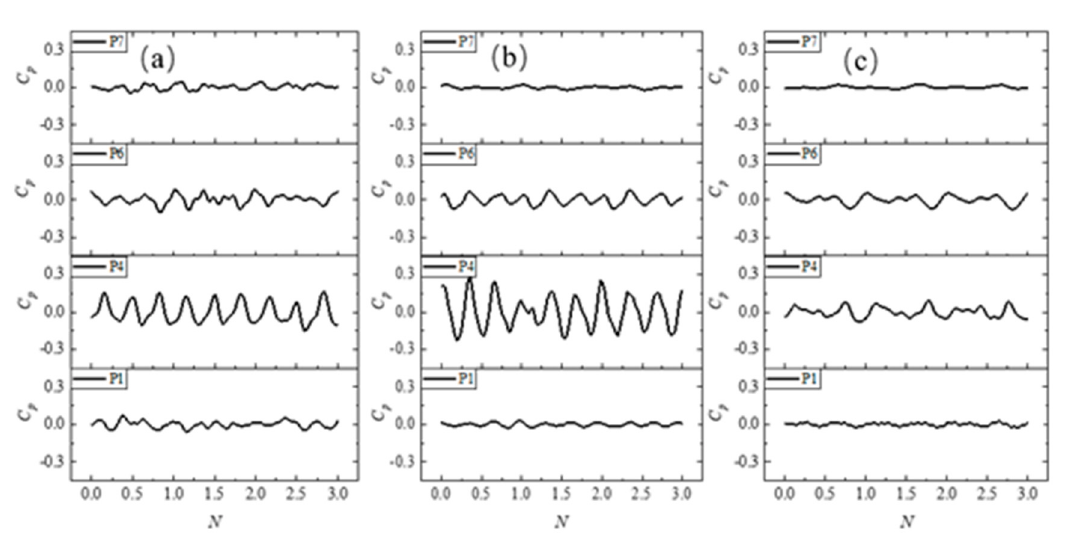
Figure 8. Time domains of pressure fluctuations under different flowrate conditions: ( a ) 0.6 Q d ; ( b ) 1.0 Q d ; ( c ) 1.1 Q d .